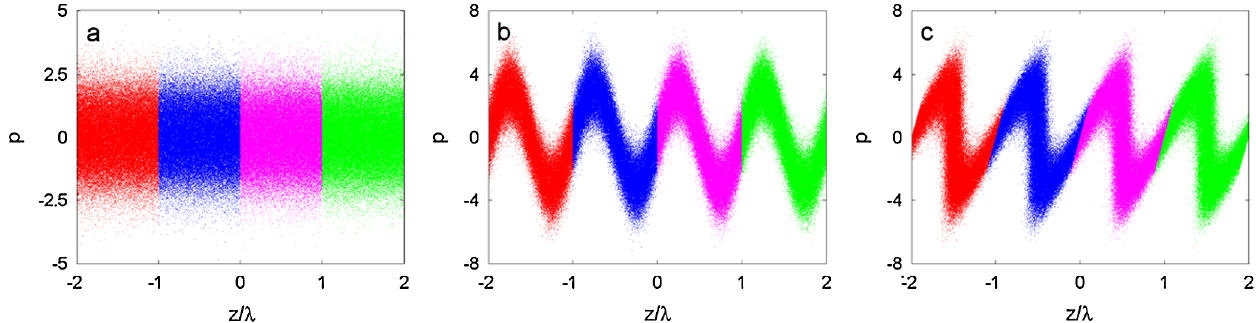
FIG. 3. (Color) The phase space evolution in the classic HGHG scheme. Different colors indicate four regions of unit laser wavelength in the initial phase space of the